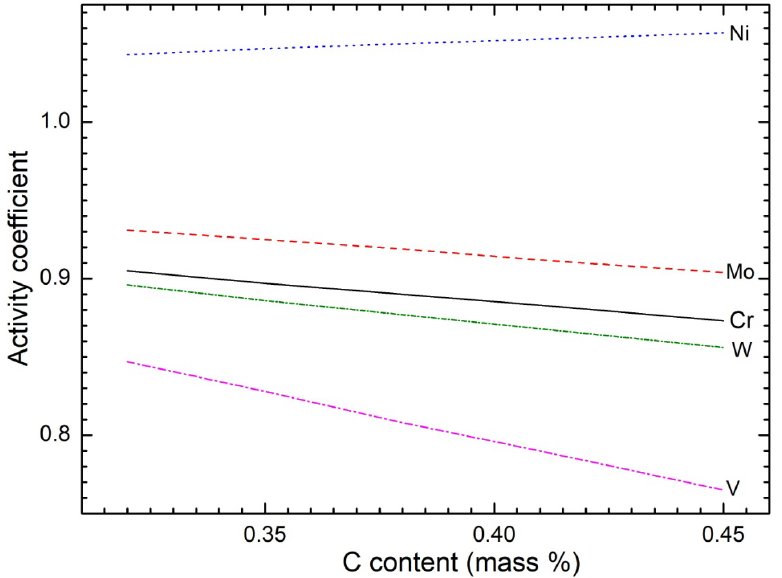
Figure 3. Effect of C content on activity coefficients of alloying elements at 1873 K.